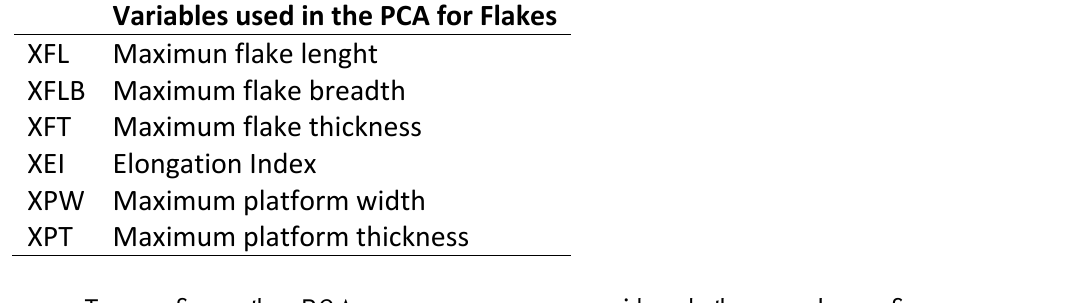
Table 2. Attributes for flake analysis Variables used in the PCA for